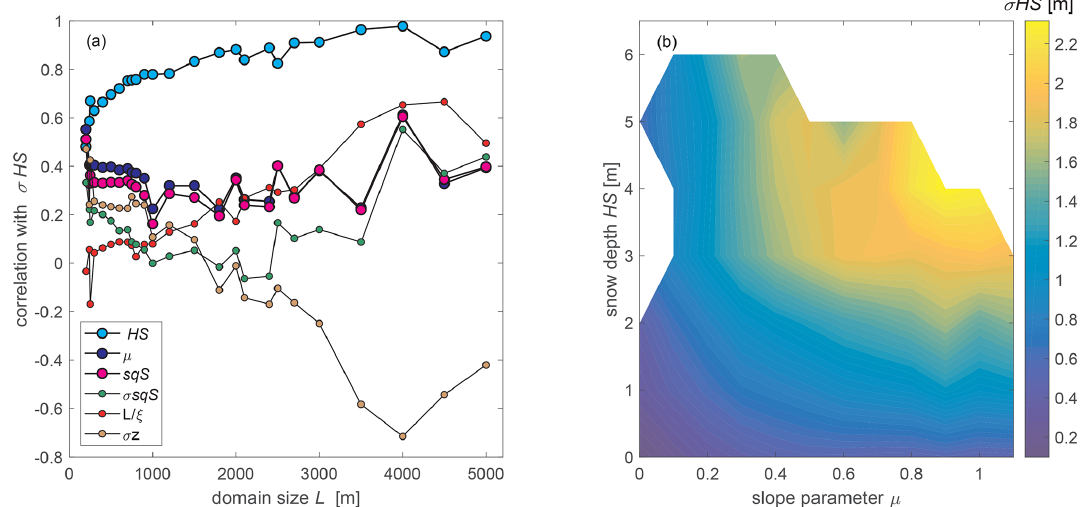
Figure 8. (a) Correlation coefficients between σ HS and various parameters as a function of domain size L . (b) Standard deviation of snow depth σ HS as a function of HS and µ .